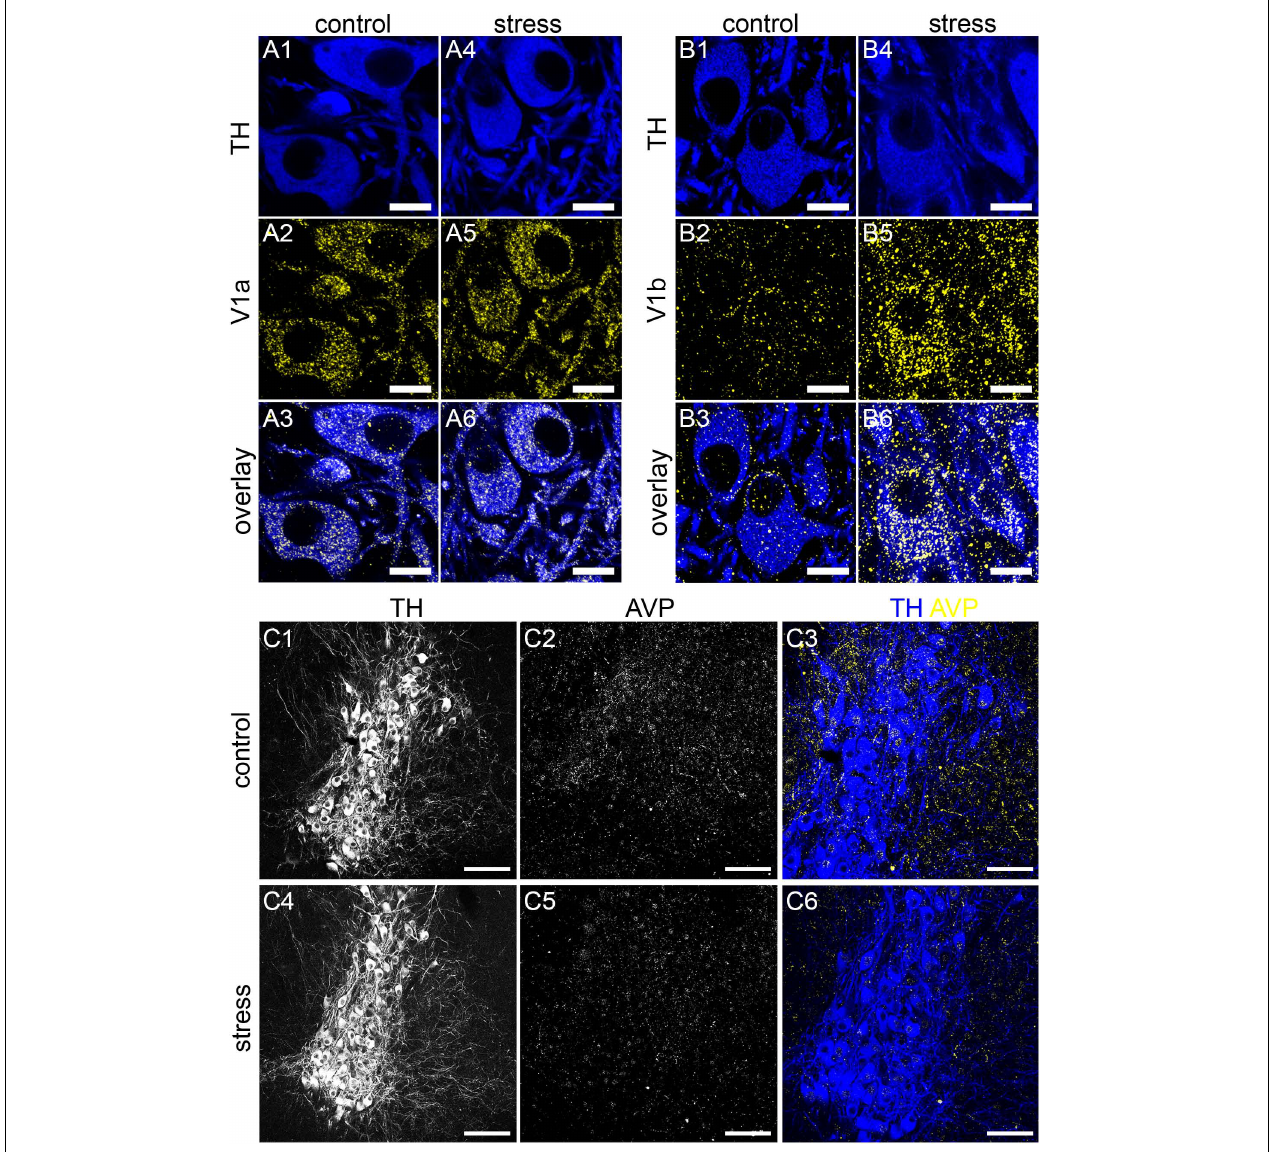
FIGURE 9 | Acute stress engages the AVP-V1a-b system in the LC. (A1) Shows TH immunoreactivity in the LC from a control mouse. (A2) Shows, in the same field of view, immunoreactivity for the V1a receptor. (A3) Is an overlay of (A1,A2) . (A4) Shows TH immunoreactivity in the LC from tissue of a mouse exposed to 1 h of restraint stress and killed an hour later, processed and imaged under conditions identical to control subjects. (A5) Shows, in the same field of view, immunoreactivity for V1a, with no discernible difference in labeling pattern and intensity evident between stress and control samples. (A6) Is an overlay of (A4,A5) . (B1) Shows TH immunoreactivity in the LC from a control mouse. (B2) Shows, in the same field of view, immunoreactivity for the V1b receptor. (B3) Is an overlay of (B1,B2) . (B4) Shows TH immunoreactivity in the LC from tissue of a mouse exposed to 1 h of restraint stress. (B5) Shows, the same field of view, immunoreactivity for V1b. A dramatic stress-induced increase in the intensity of V1b signal is noticeable, both on cell surfaces but also in cytoplasmic components, suggesting a stress-induced internalization, presumably via prolonged activation. (B6) Is an overlay of (B4,B5) , which exemplifies the differences between the immunoreactivity patterns in control and stress samples. (C1) Shows TH immunoreactivity in the LC from a control mouse. (C2) Shows, the same field of view, immunoreactivity for AVP. (C3) Is an overlay of (C1,C2) with TH and AVP pseudo-colored blue and yellow respectively. (C4) Shows TH immunoreactivity in the LC from tissue of a mouse exposed to 1 h of restraint stress and killed an hour later, processed and imaged under conditions to identical control subjects. (C5) Shows, the same field of view, immunoreactivity for AVP. A stress-induced decrease in the intensity of AVP signal is noticeable as well as the relative lack of immunoreactive varicosities. This is exemplified in (C6) , when compared to (C3) . Scale bars (A,B) 10 µ m; (C) 100 µ